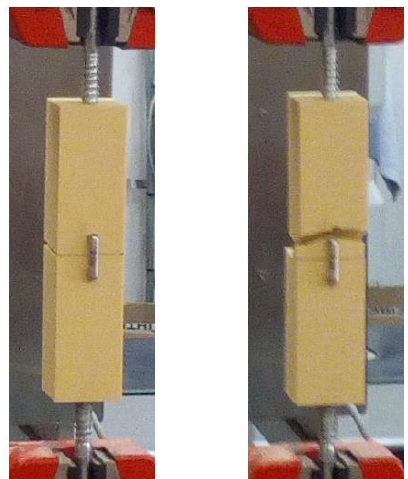
Figure 18. The model at the end of the experiment.